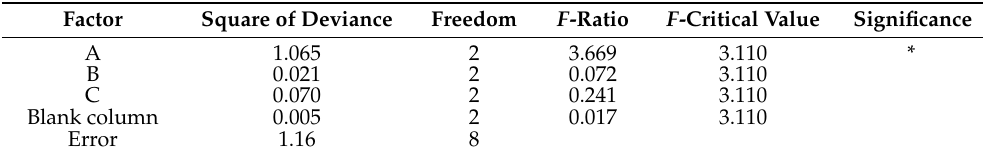
Table 10. Analysis of